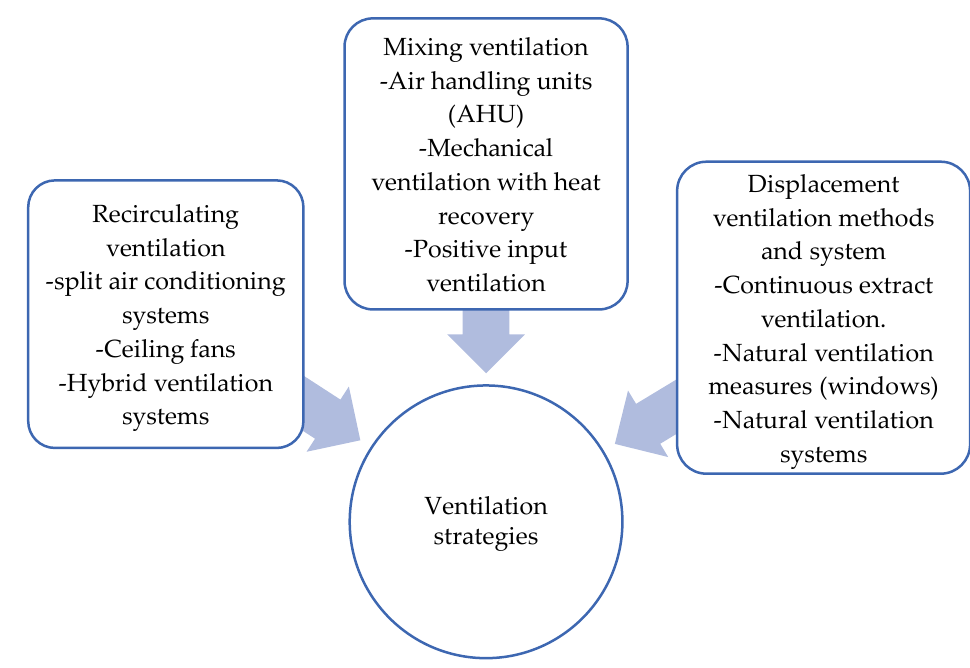
Figure 5. Ventilation strategies by airflow dynamics.